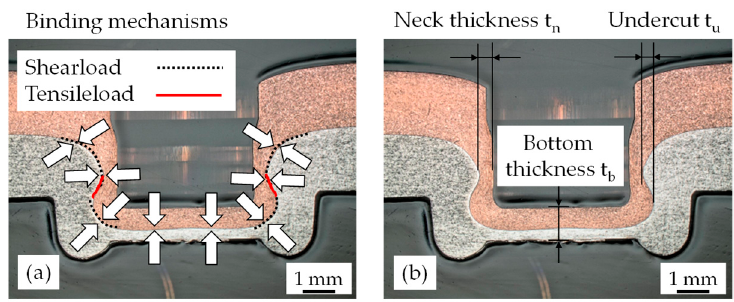
Figure 2. Local binding mechanisms ( a ) and geometric features ( b ) at clinch points.